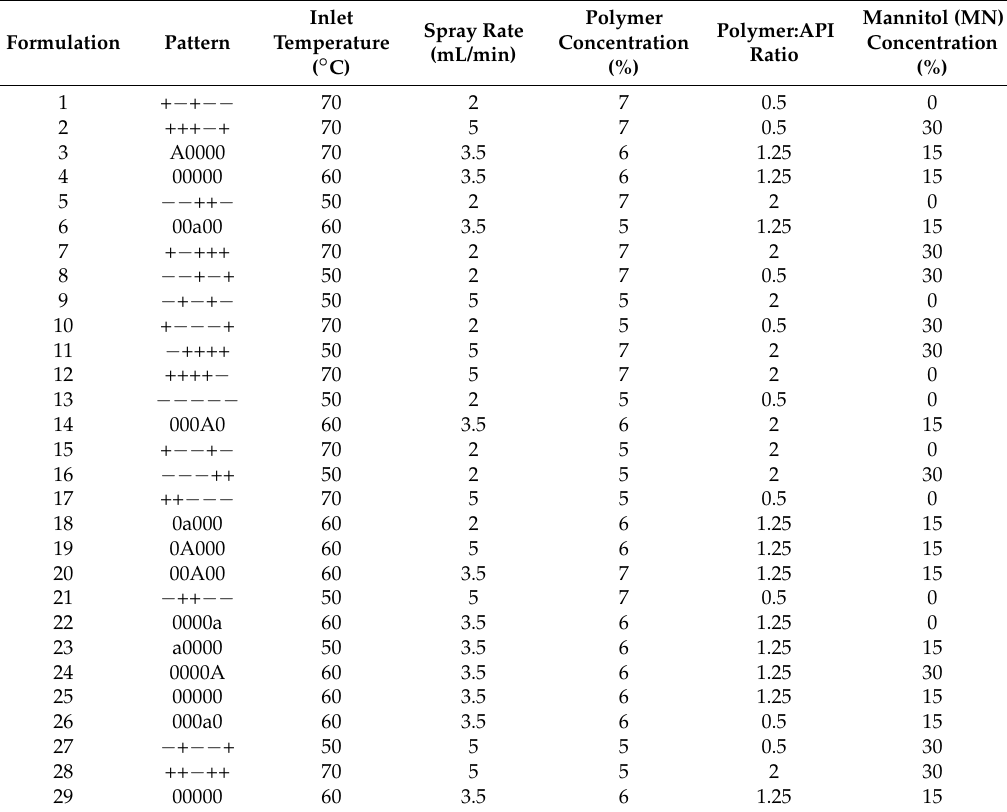
Table 1. The plan of experiments concerning preparation of formulations from ethylcellulose (EC) organic solutions with mannitol